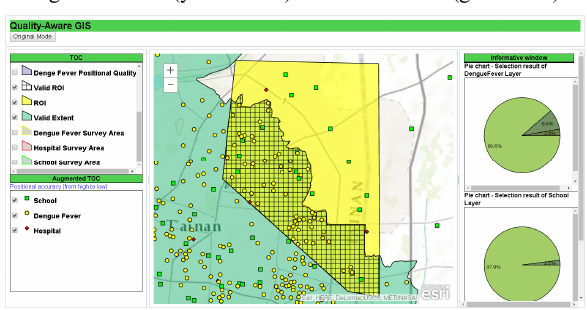
Figure 11. Valid extent of ROI (grass green filling with cross line pattern)